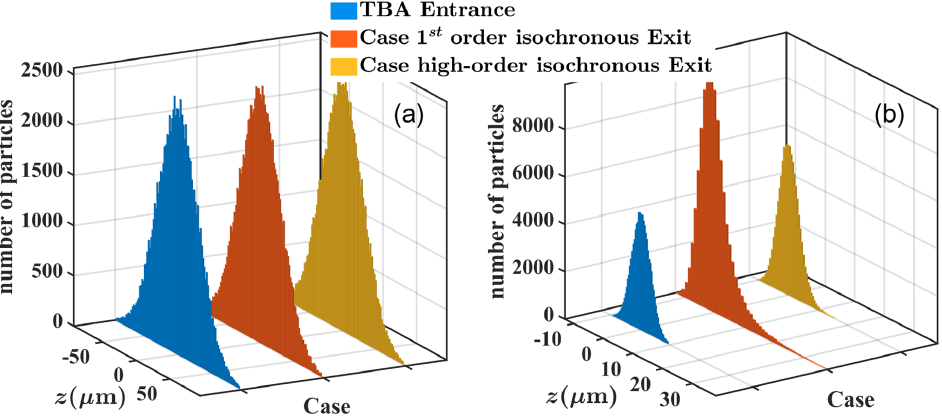
FIG. 9. Comparison of the current prole using conventional rf beam parameters (a) and LPA beam parameters (b).